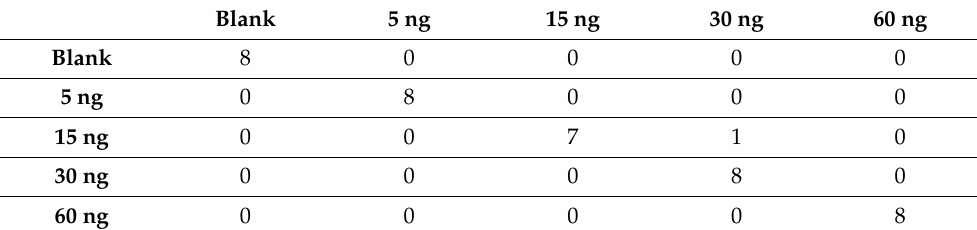
Table 2. Confusion matrix for the TCA measurements with the RBF neural network. Actual values (rows); predicted values (columns).